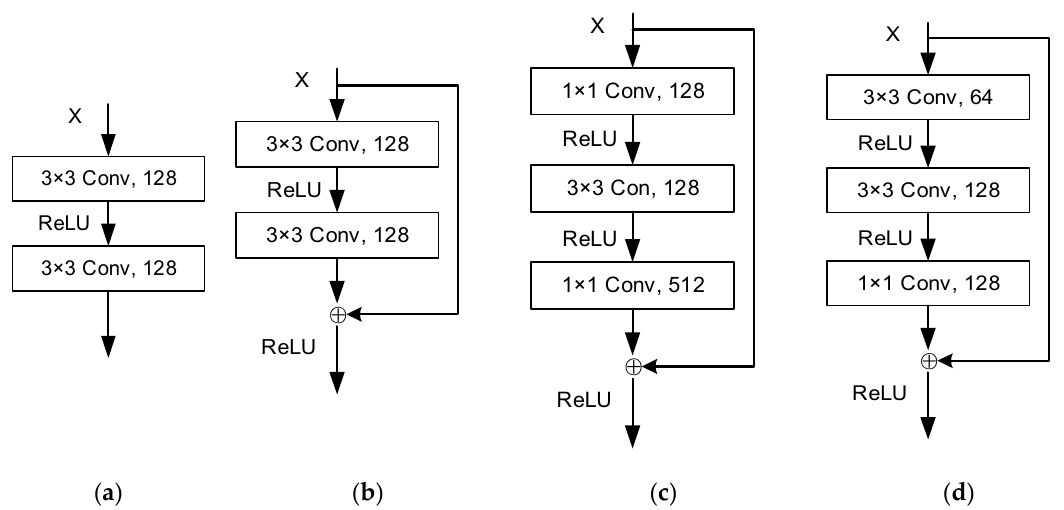
Figure 2. Illustration of the ResBlock structure. ( a ) plain neural unit used in U-Net; ( b ) basic residual unit used in ResNet-34; ( c ) “bottleneck” shaped residual unit used in ResNet-50/101/152; ( d ) the designed ResBlock used in DeepResUnet.